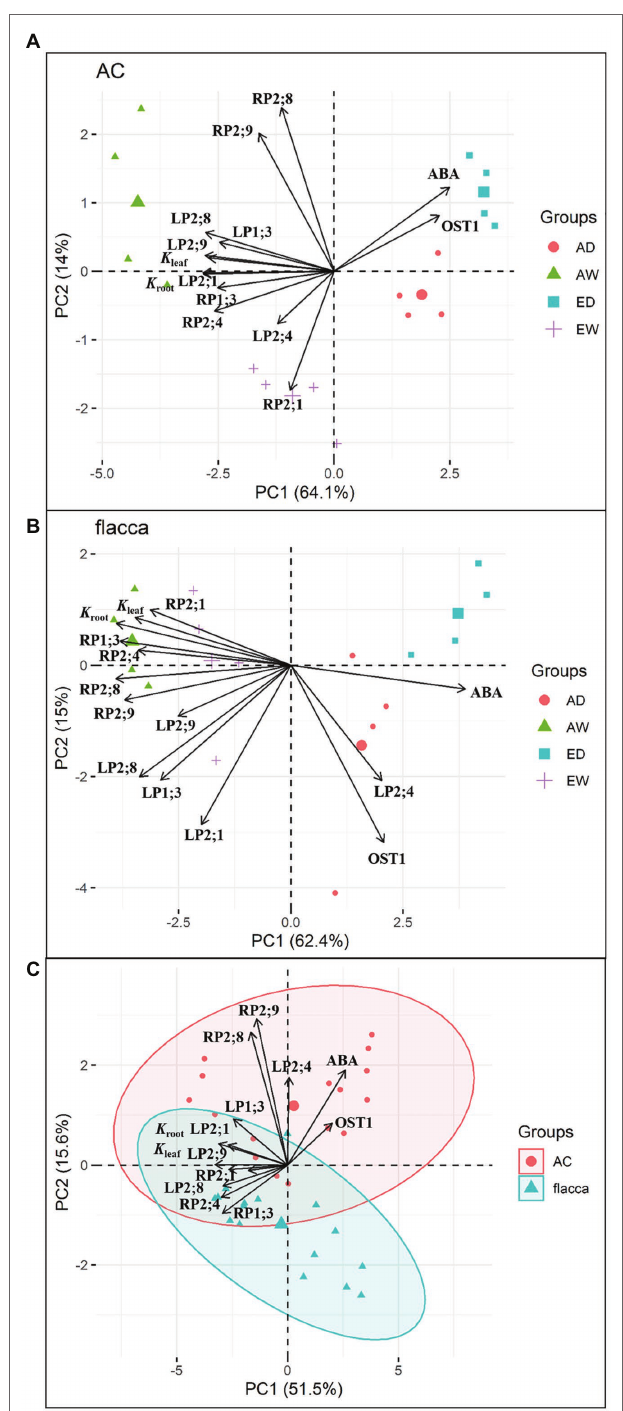
FIGURE 8 | Principal component analysis of tomato leaf and root hydraulic conductance ( K leaf and K root ), xylem sap ABA concentration (ABA), gene expression of five leaf PIP s (LP), root PIP s (RP) and OST1 for (A) AC, (B) flacca , and (C) two genotypes grown under ambient (400 ppm) and elevated (800 ppm) atmospheric CO 2 concentrations after progressive soil drying. AW: a [CO 2 ] and well water; AD: a [CO 2 ] and drought stress; EW, e [CO 2 ] and well water; ED: e [CO 2 ] and drought stress. The contribution of each PCA axis (PC1 and PC2) is indicated on the graph.